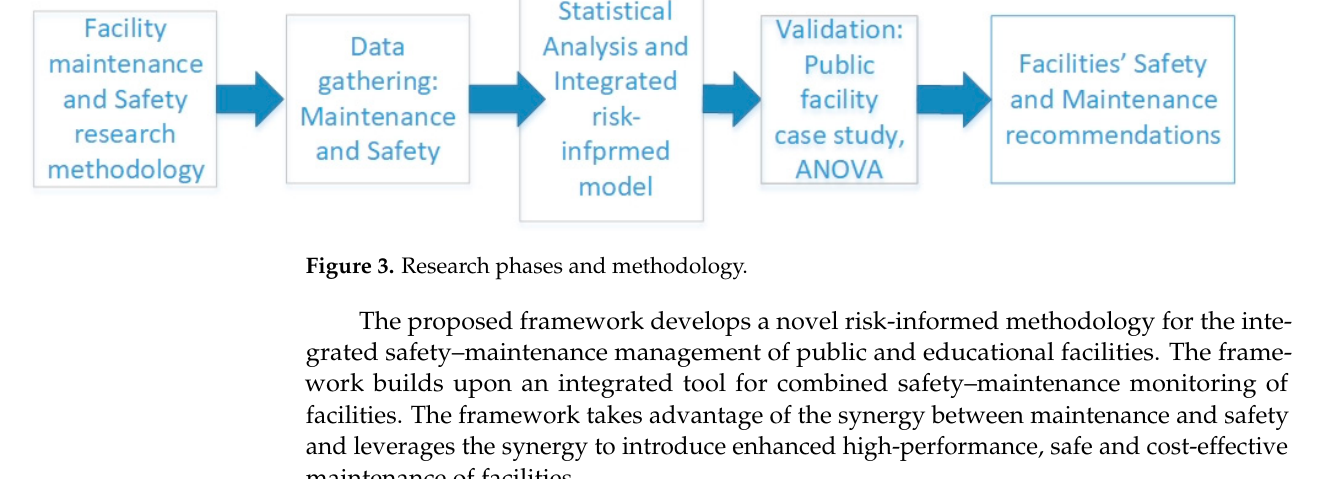
Figure 2. Structure of object classes for parameters of the integrated safety–maintenance in the user ‐ Interface.